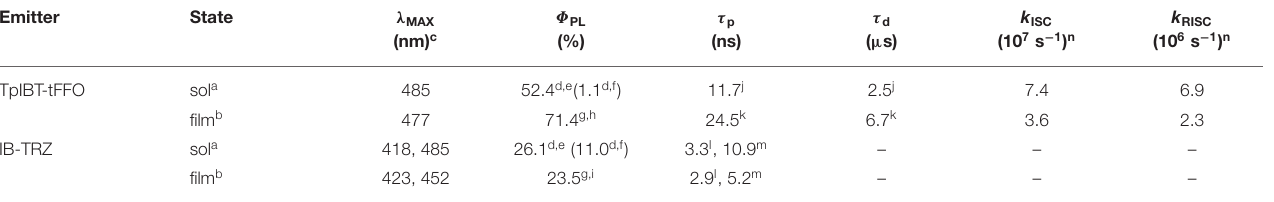
TABLE 3 | Photophysical parameters of λ MAX , Φ PL , τ p , τ d , k ISC , and k RISC for TpIBT-tFFO and IB-TRZ.